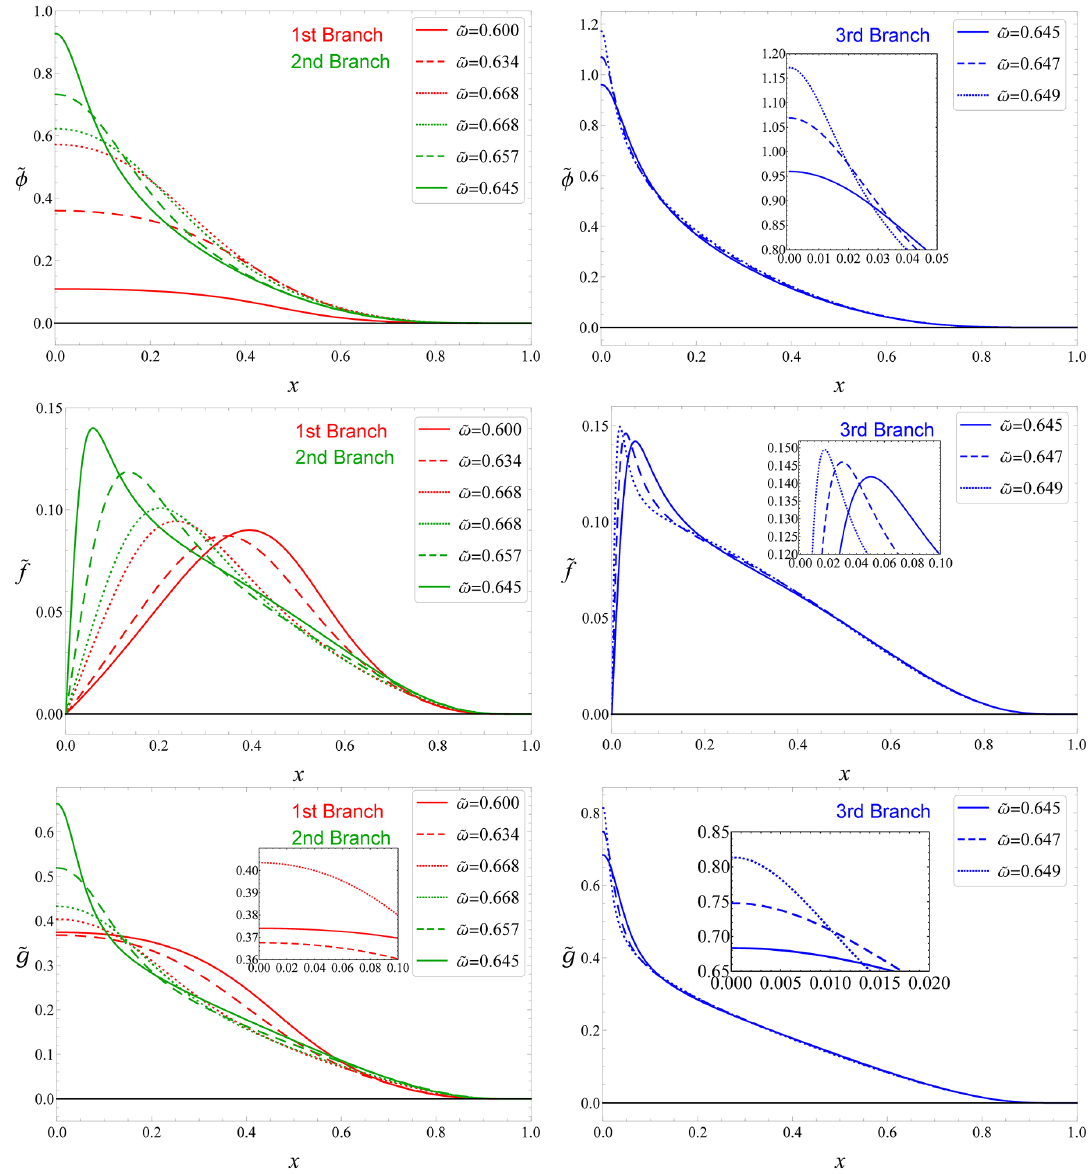
Figure 3. Scalar field function ˜ φ (top panels) and Dirac field functions ˜ f (middle panels) and ˜ g (bottom panels) as functions of x with several values of synchronized frequency ˜ ω , where the field functions on the first, second and third branches are represented by the red, green and blue lines. All solutions have ˜ µ D = 0 . 781 and ˜ µ S = 1